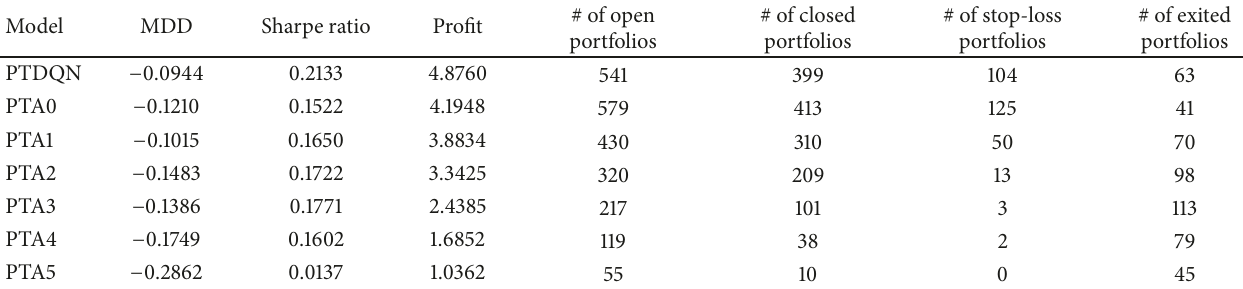
Table 7: Average top-5 performance results for XOM and CVX using TLS within the training